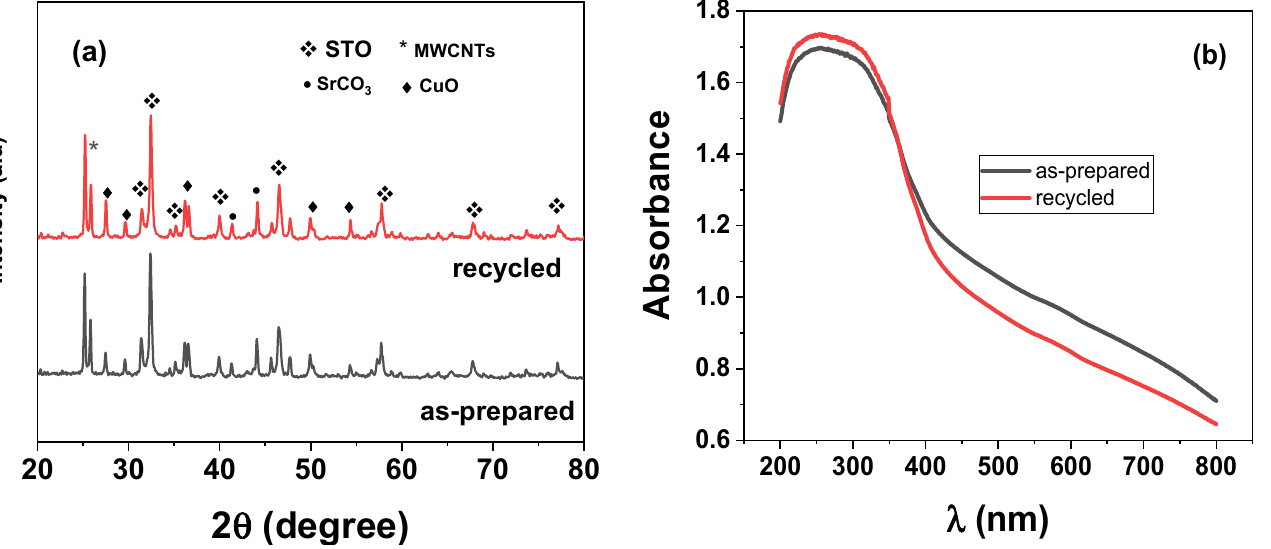
Figure 13. XRD patterns ( a ), DRS spectra ( b ) of the as-prepared and recycled 5% CuO/STO/MWCNTs nanocomposites.